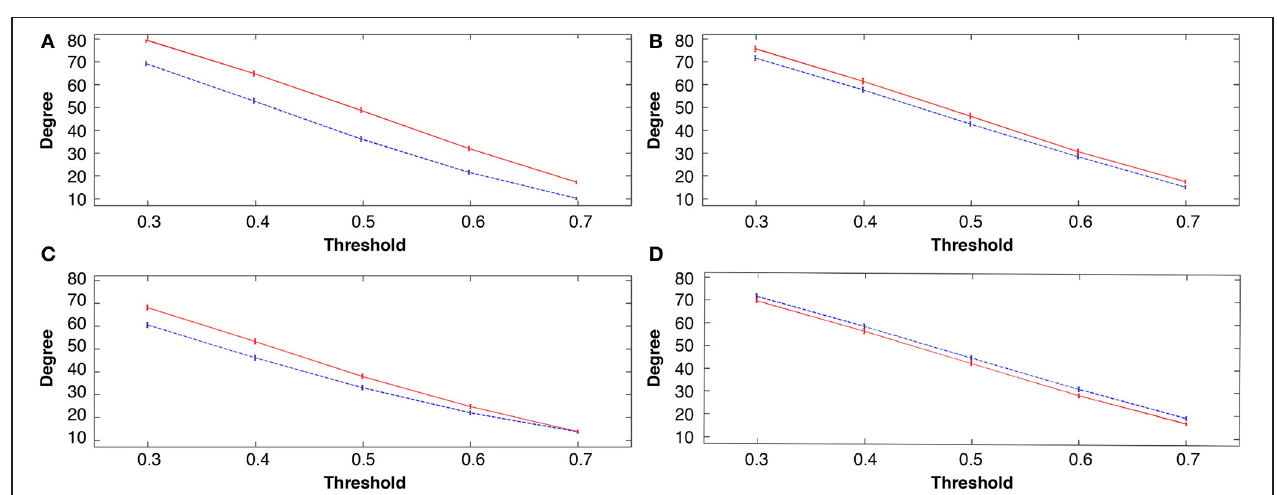
FIGURE 4 | Group mean degree connectivity at all costs before and following the four tasks, in all figures rest 1 (pre-task in blue) and rest 2 (post-task in red); (A) explicit SRTT task 1; (B) implicit SRTT task 2;